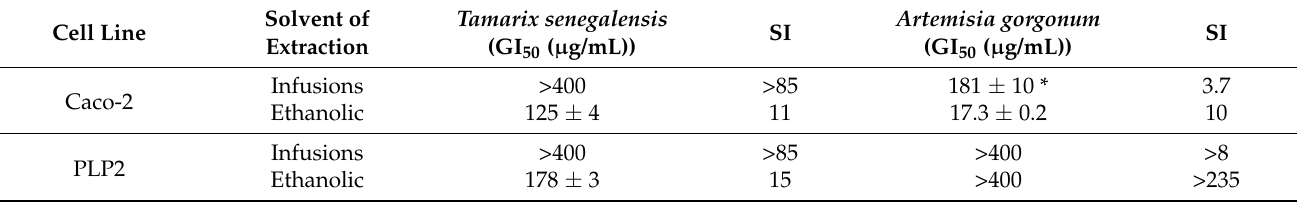
Table 3. In vitro cytotoxicity activity of the ethanolic and aqueous